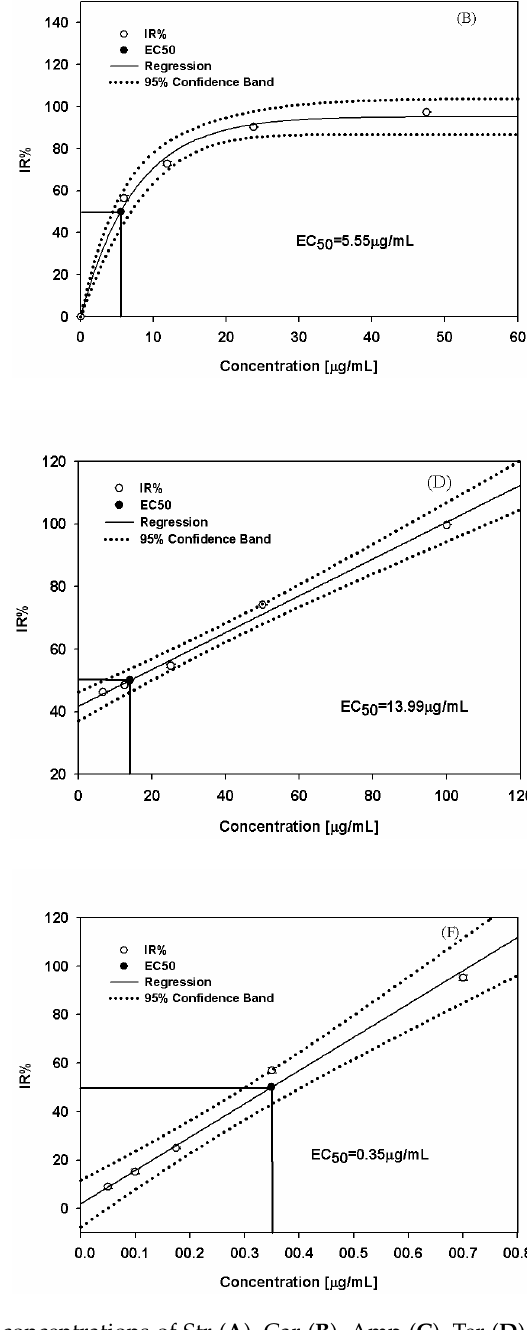
Figure 2. IR% of PAO1-CE at different concentrations of Str ( A ), Car ( B ), Amp ( C ), Ter ( D ), Tmp ( E ), and Cip ( F ). IR: luminescence inhibition ratio; EC 50 : concentration for 50% of maximal effect; Regression: fitted curve. Each point represents a mean value ± SE of three replicates. Table 1. Comparative results between the PAO1-CE biosensor and MIC detection.